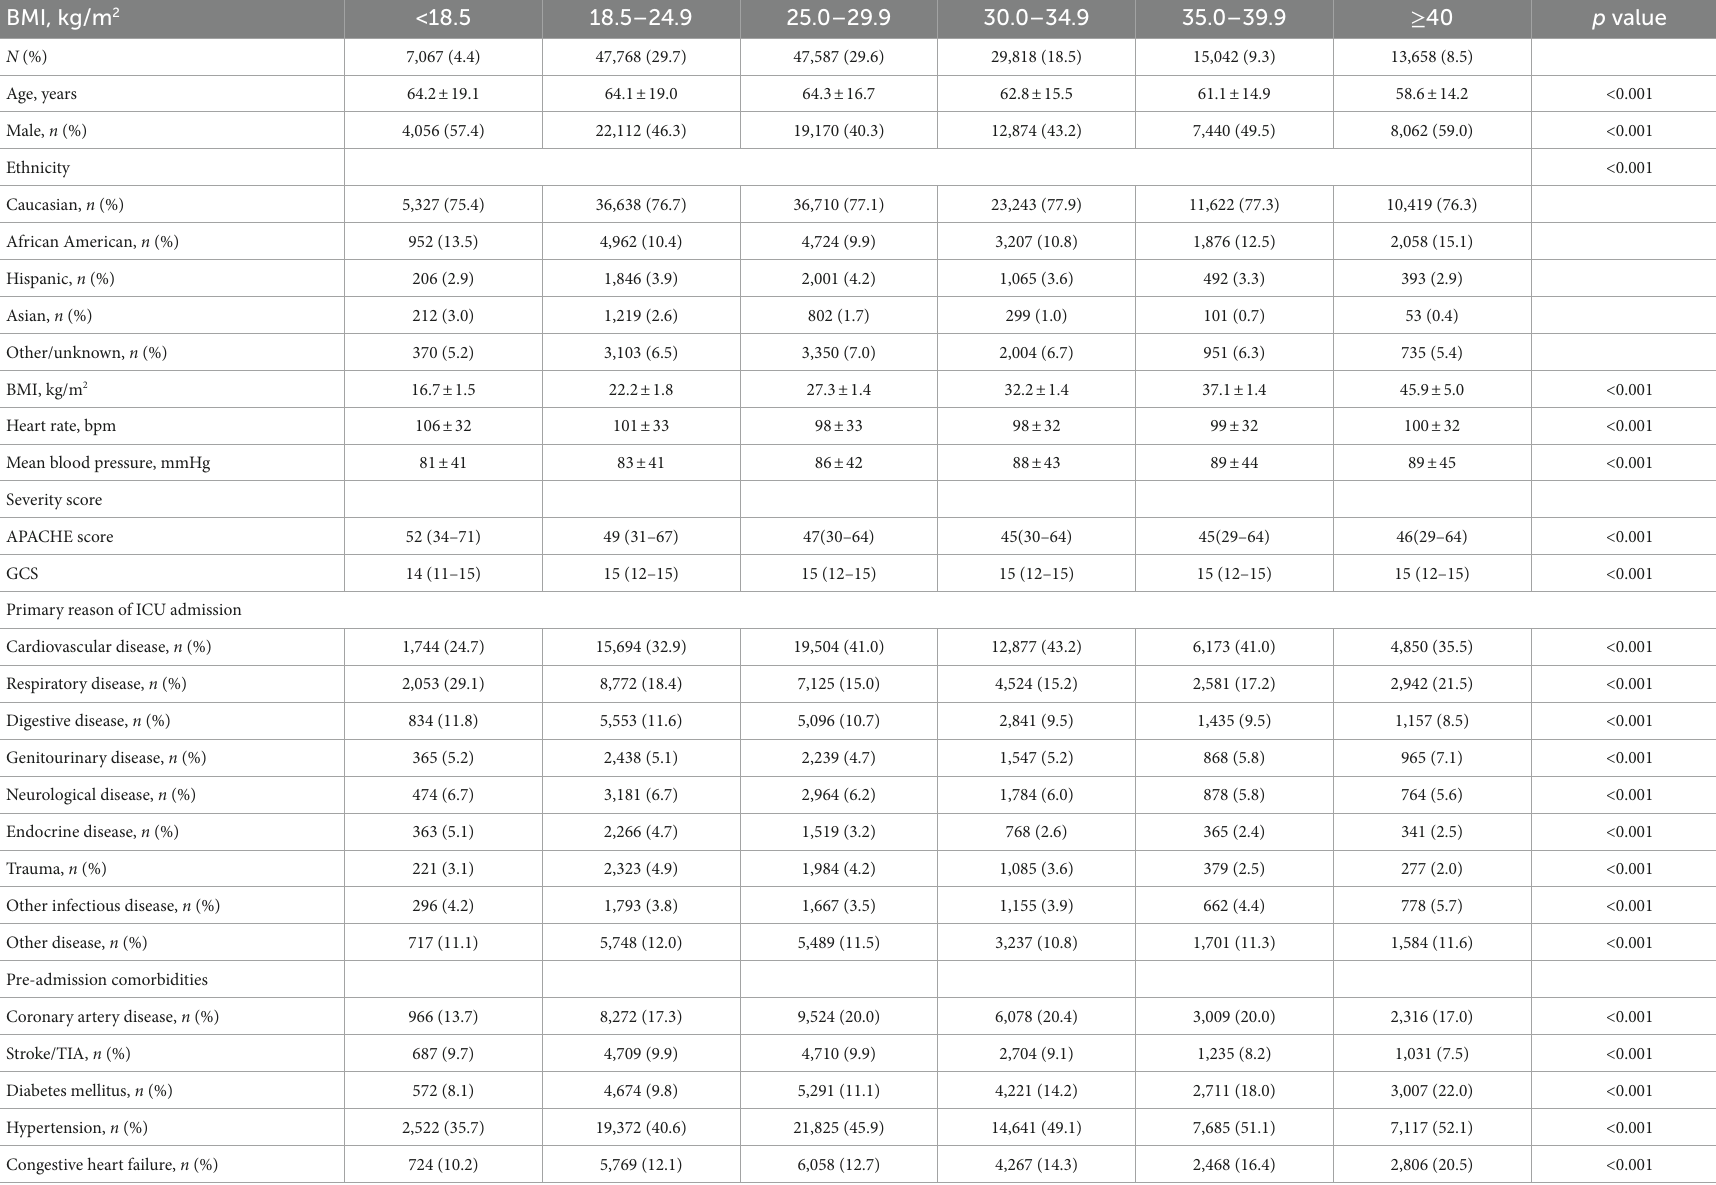
TABLE 1 Baseline characteristics of individuals by BMI